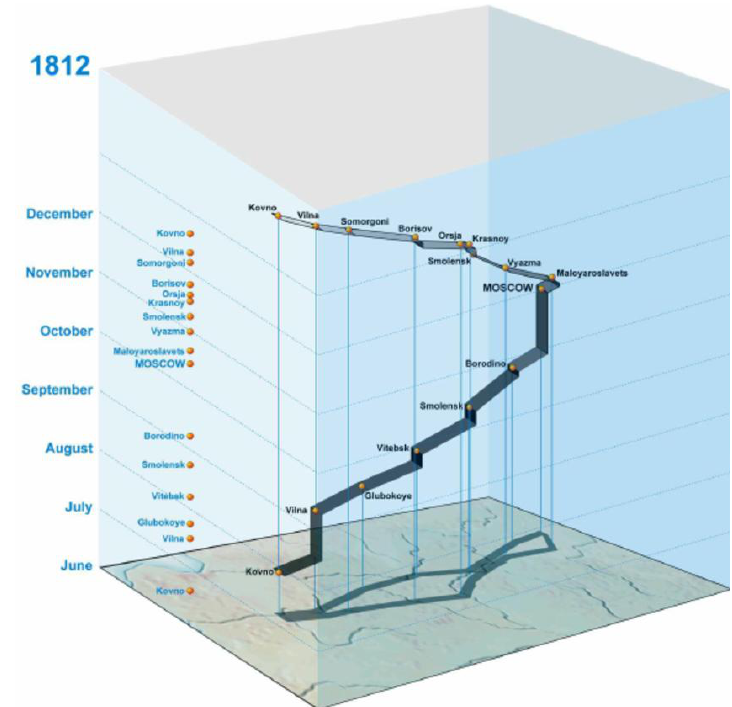
Figure 6. Menno-Jan Kraak at the International Institute of Geoinformation Sciences and Earth Observation, Netherlands